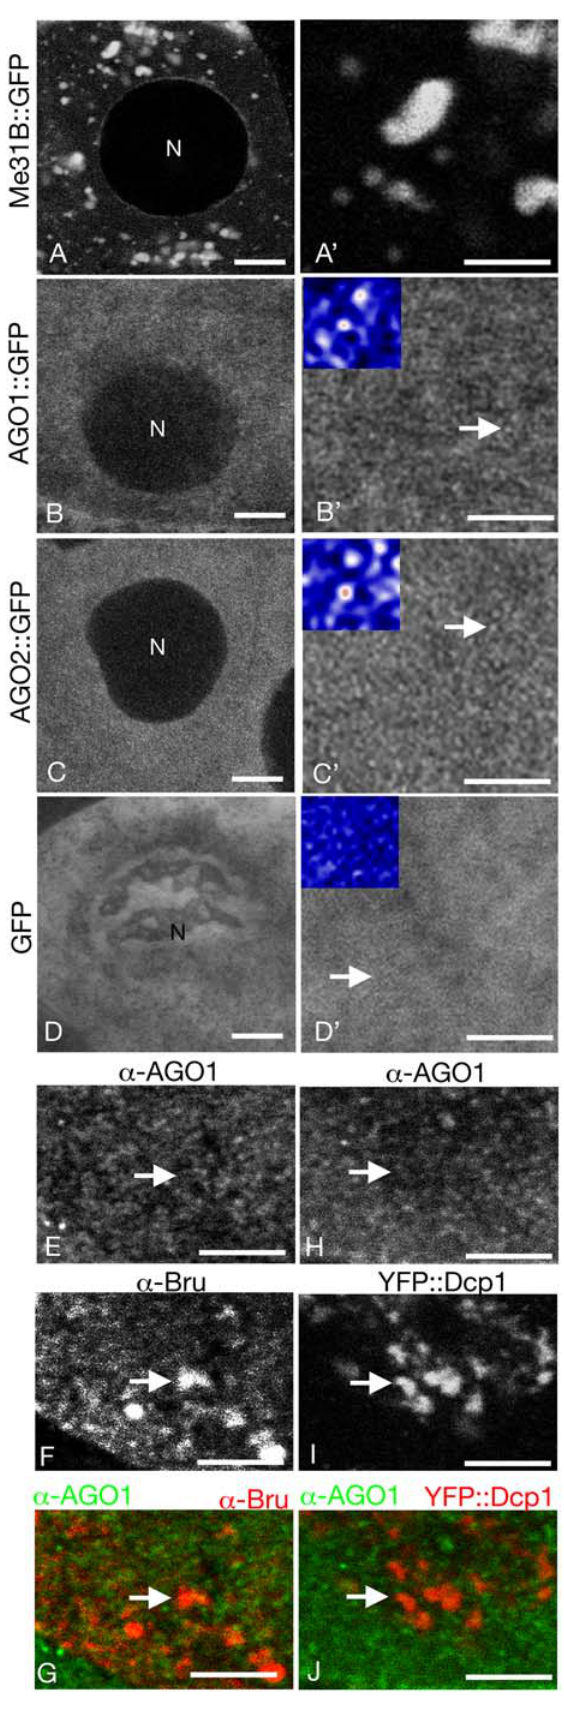
Figure 3. Subcellular distribution of AGO and AGO::GFP proteins in the ovary. Panels A–D show the distributions of GFP fusion proteins in the nurse cells of live stage 9 egg chambers, with higher magnification images in A’–D’. Scale bars are 10 m m in A–D and 5 m m in A’–D’. A, Me31B::GFP; B, AGO1::GFP; C, AGO2::GFP; and D, GFP. The lower resolution images (with the nuclei marked as N) demonstrate the absence of any detectable concentration of either of the AGO::GFP fusion proteins in localized regions of the cytoplasm, as would be the case if they are enriched in sponge bodies. Sponge body distribution is shown by Me31B::GFP. The higher resolution images reveal that both AGO::GFP fusion proteins are distributed in many small puncta that are fairly evenly spread throughout the cytoplasm (examples of individual puncta are indicated by arrows). By contrast, GFP alone (D’) is more uniform and lacks puncta of the size seen for the fusion proteins. The insets in B’–D’ are higher resolution images of the regions in B’–D’ indicated by arrows. The representation of each fluorescence value was changed in ImageJ (NIH) from a black and white scale (look up table; LUT) to the Union Jack LUT which represents the lowest fluorescence as black and progressively higher fluorescence levels are blue, white, and then red. AGO1::GFP and AGO2::GFP fluorescence is concentrated in puncta (appearing white and red in the insets in B’,C’) that are not observed for GFP (inset in D). Panels E–G show a portion of a nurse cell of a fixed stage 9 egg chamber probed with antibodies to detect AGO1 (E) and Bru (F), or both (G; AGO1 in green, Bru in red). Panels H–I are similar, with detection of AGO1 (H), dDcp1::YFP (I) or both (J; AGO1 in green, dDCP1::YFP). The AGO1 distribution is particulate, just as for the AGO1::GFP fusion protein, and shows no enrichment in sponge bodies, for which Bru and dDcp1::YFP are markers ([41,55]). Scale bars are 5 m